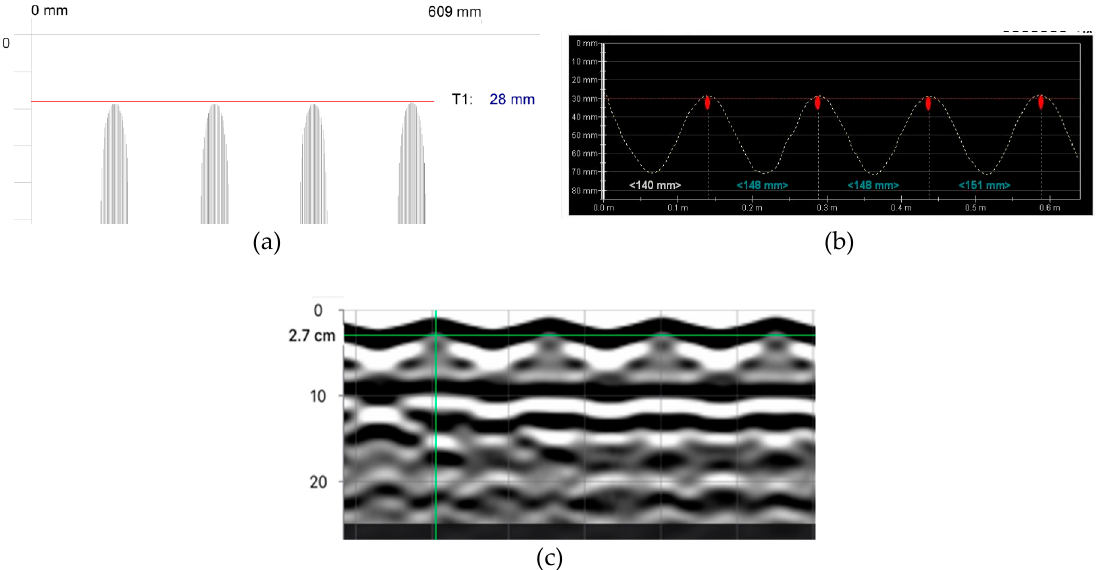
(c) Figure 13. Testing specimens using: ( a ) electromagnetic device (1), ( b ) electromagnetic device (2), and ( c ) radar device (3) 6. Test results 6.1. AAC precast lintels (AAC) 6.1.1. Stirrups tests The stirrups were tested at the beam side as line and area scans. Line scans could be only used